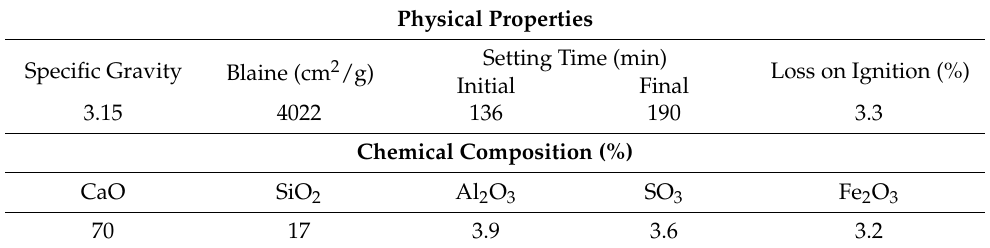
Table 2. Physicochemical properties of the ordinary Portland cement (OPC) used.